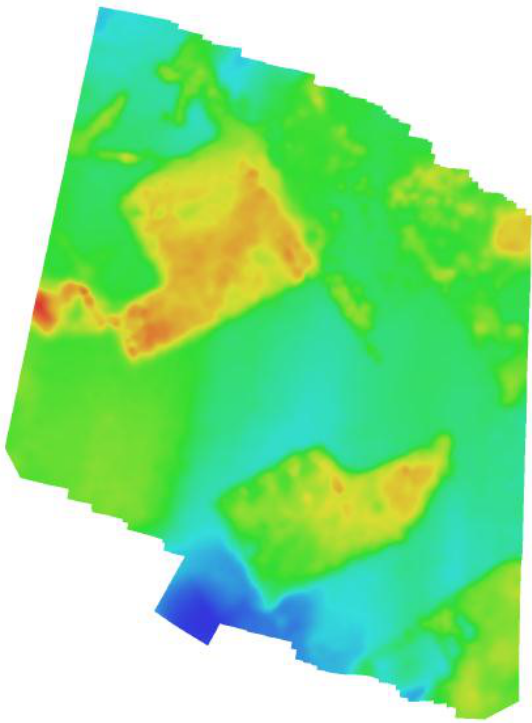
Figure 12 digital surface model derived from the panchromatic images of the MEDUSA engineering camera Figure 13 colour image reconstruction of the 3 bands making use of position and attitude directly from GPS and IMU.